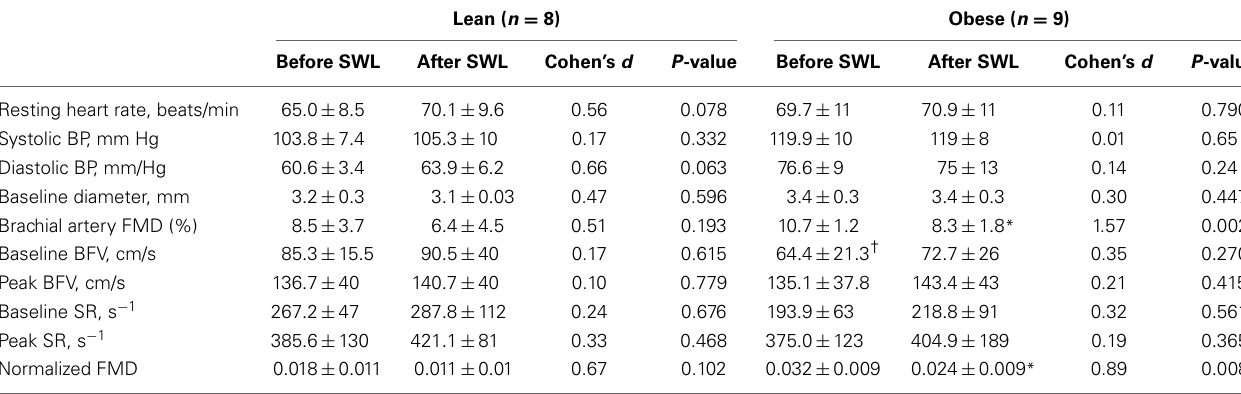
Table 2 | Hemodynamic and vascular characteristics of participants.